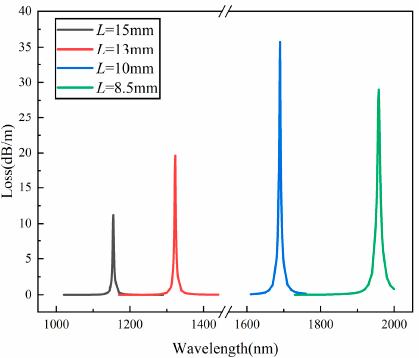
Figure 5. Confinement losses for different pitch L.